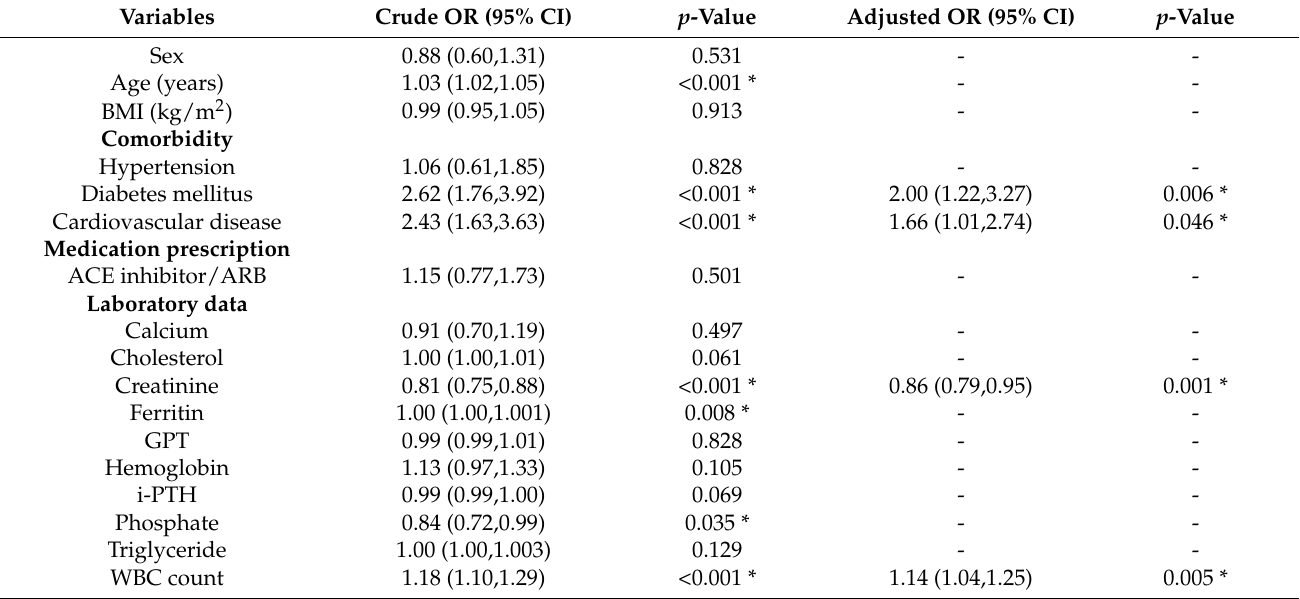
Table 3. Logistic regression model-based estimated odds ratios of the low albumin and high globu- lin group (group D) compared with other albumin – globulin groups (reference).